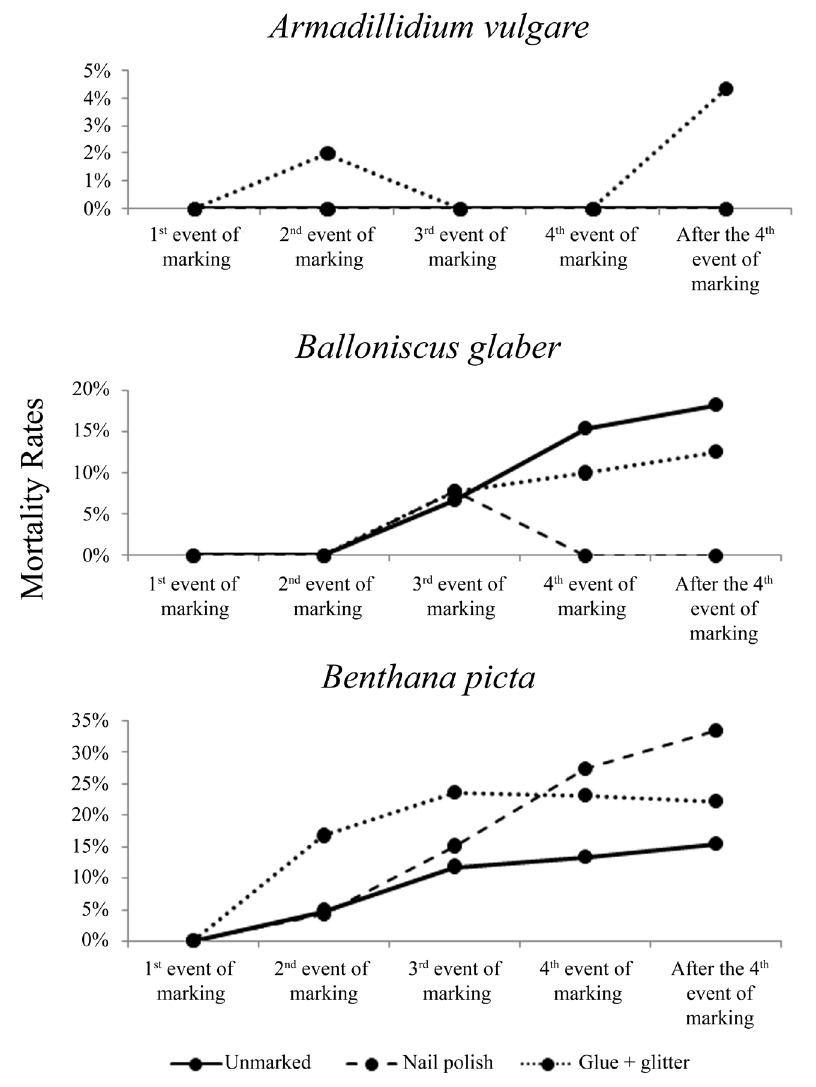
Figure 5. Mortality rates for the three woodlice species, unmarked and marked with nail polish and glue + glitter. The events of marking corresponding to the 1 st , 8 th , 15 th , 22 th and 28 th day,